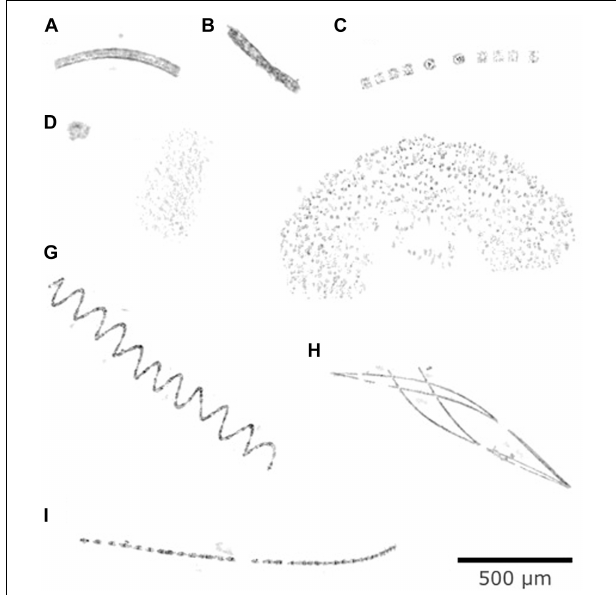
FIGURE 2 | Example vignettes from profile DY086-034 near South Georgia showing most likely (A) Fragilariopsis kerguelensis , (B) fecal pellet, (C) Thalassiosira sp., (D) compact phytodetritus, (E) loose phytodetritus, (F) Chaetoceros socialis , (G) Eucampia antarctica , (H) Thalassiothrix sp., and (I) chain-forming